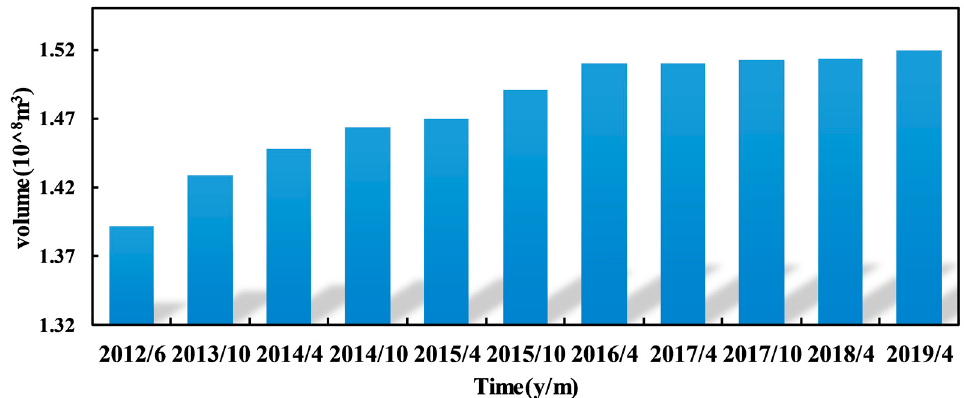
Figure 10. Statistical change of volume under middle water level in river section.